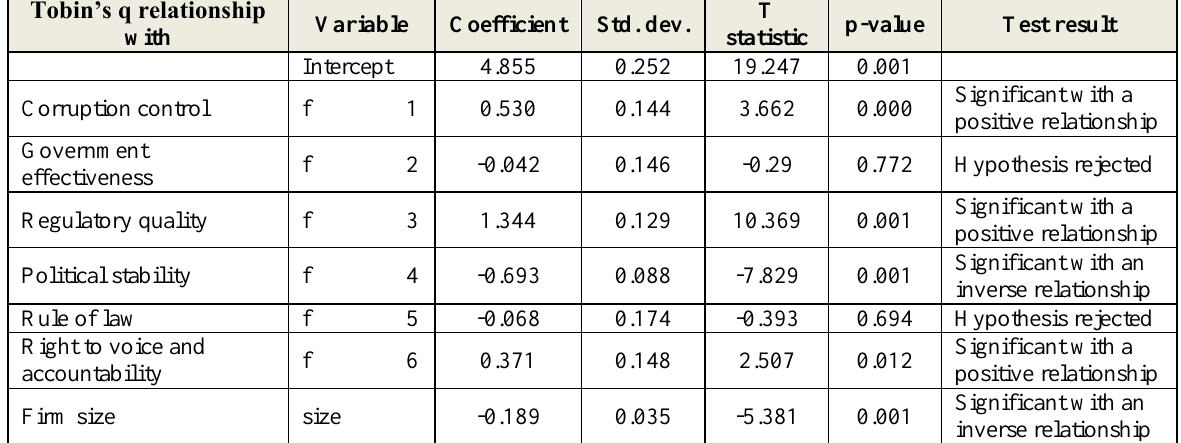
Table 5. the relationship between Tobin’s q ratio and governance